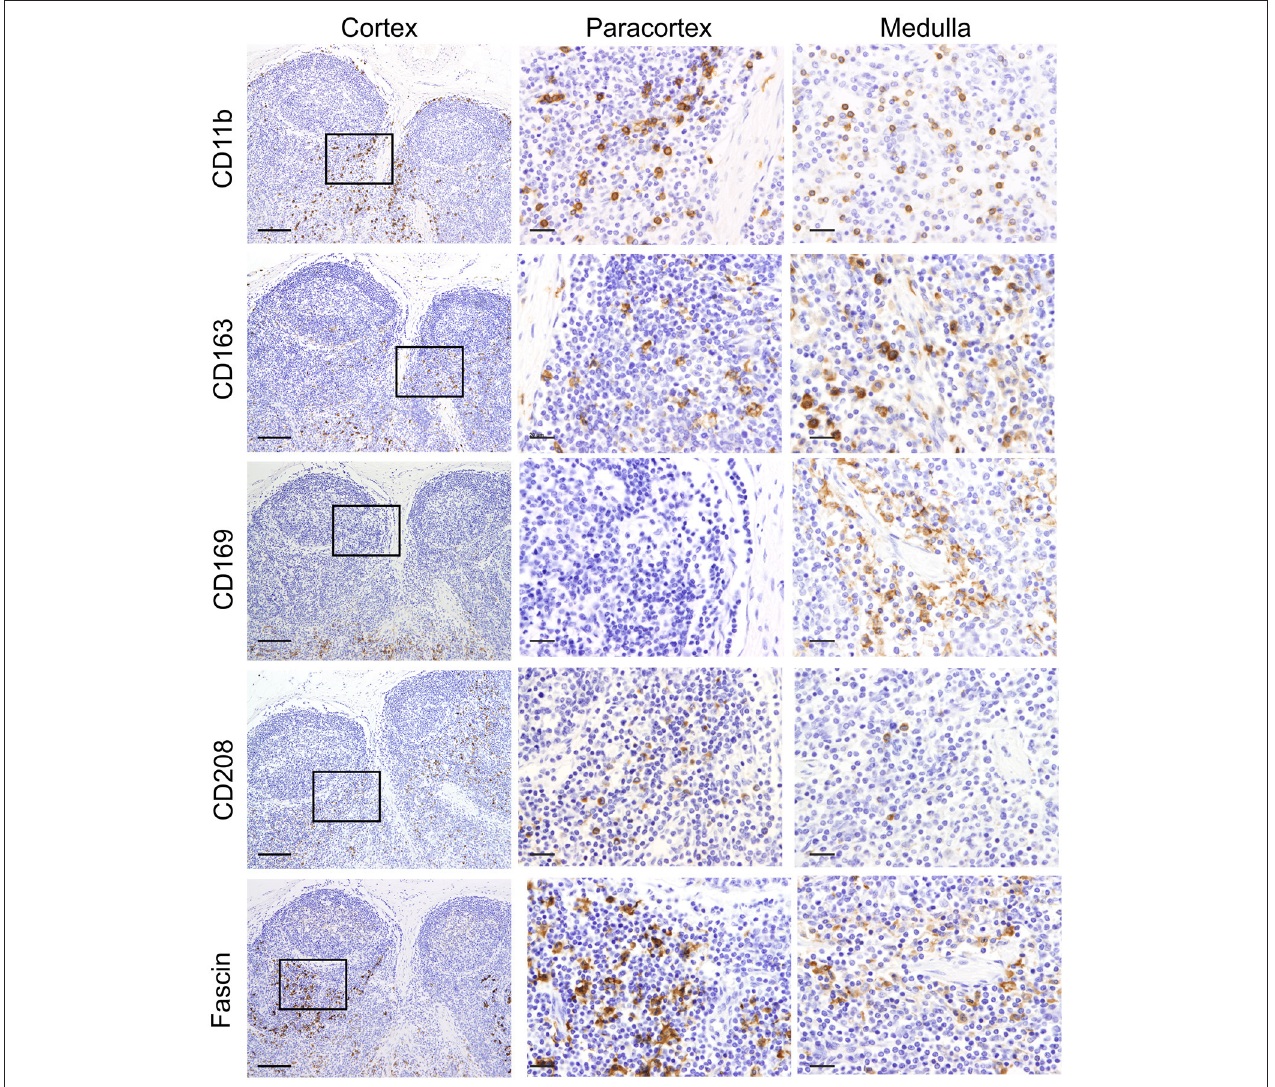
FIGURE 2 | Identification of markers for sheep macrophages and dendritic cells. Representative immunohistochemistry micrographs of sheep lymph node sections fixed using zinc salt solution. Sequential tissue sections stained for CD11b, CD163, CD169, CD208, and fascin. Insets show the paracortical area at higher magnification. The expression of these markers in different anatomical areas of the lymph node allowed the identification of various populations of mononuclear phagocytes. Scale bar: 100 µ m for cortex and 20 µ m for paracortex and